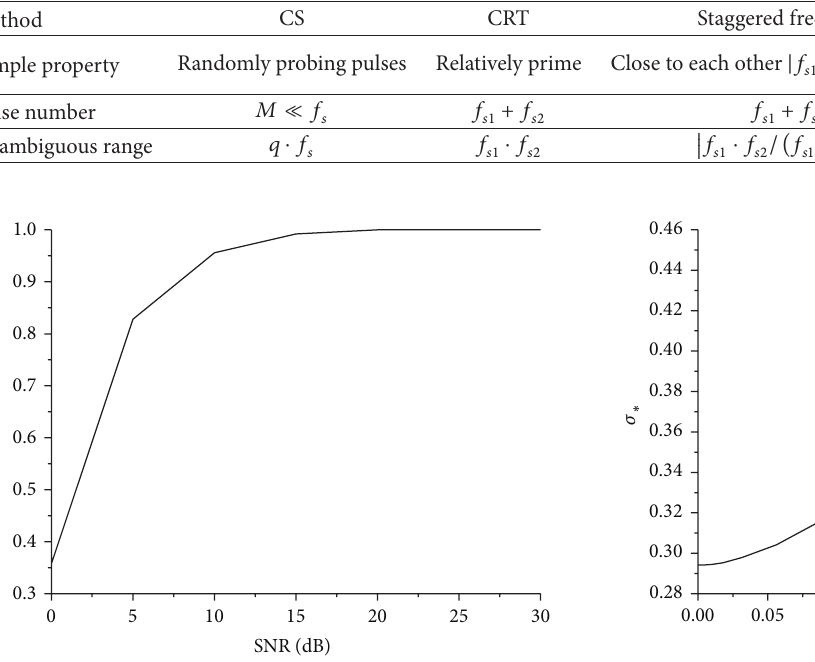
Table 2: Compared with CRT, Staggered PRF, and nonuniform sample.